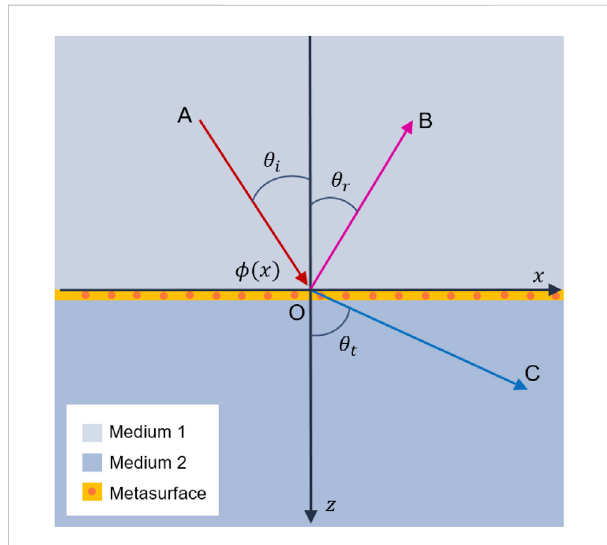
FIGURE 1 Schematic of the generalized Snell ’ s law and AM where φ ( x ) implies phase discontinuity and θ i , θ r , and θ t are the angles of incidence, re fl ection, and transmission,